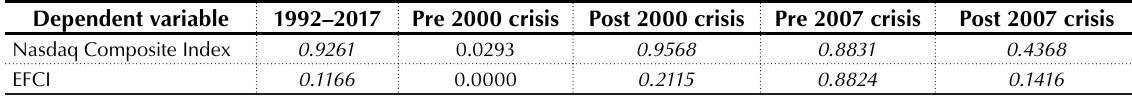
Table 8. Heteroskedasticity